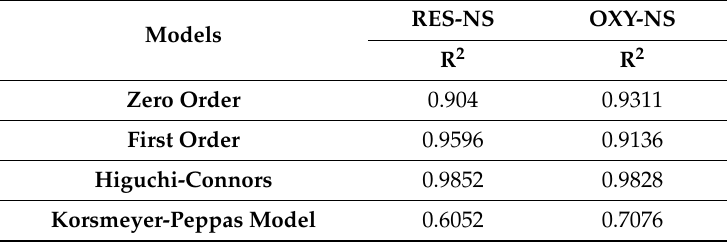
Table 2. Release kinetic models for RES-NS and OXY-NSs.